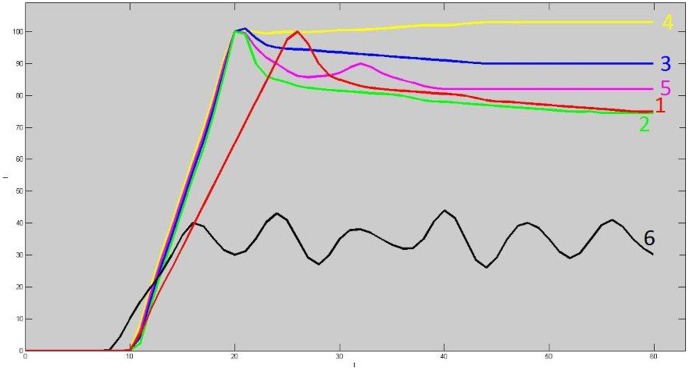
Graph of six time-intensity curves shape types (TIC).Type 1 shows slow enhancement followed by wash out phase; type 2 fast enhancement followed by wash out phase; type 3 fast enhancement followed by plateau phase; type 4 fast enhancement followed by gradual enhancement increase; type 5 fast enhancement followed by a short time wash out and by a second peak of enhancement; type 6 unclassified enhancement. Type 1–2 TIC shapes were considered indicative of fast wash-out. Type 3-4-5 were considered indicative of a slow venous wash-out.